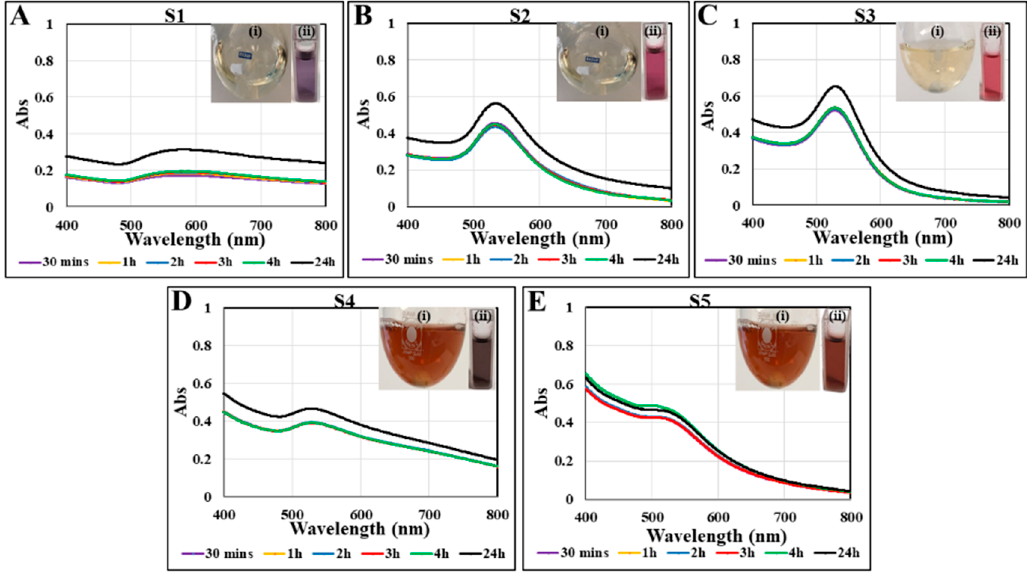
Figure 2. UV-Vis spectra of gold nanoparticles S1, ( A ); S2 ( B ); S3 ( C ); S4 ( D ); and S5 ( E ) obtained using cacao extract. Absorption spectra of samples recorded at 30 min, 1, 2, 3, 4, and 24 h from the initiation of AuNPs synthesis at 100 ◦ C. Insets displaying the AuNPs solution before (i) and after (ii)